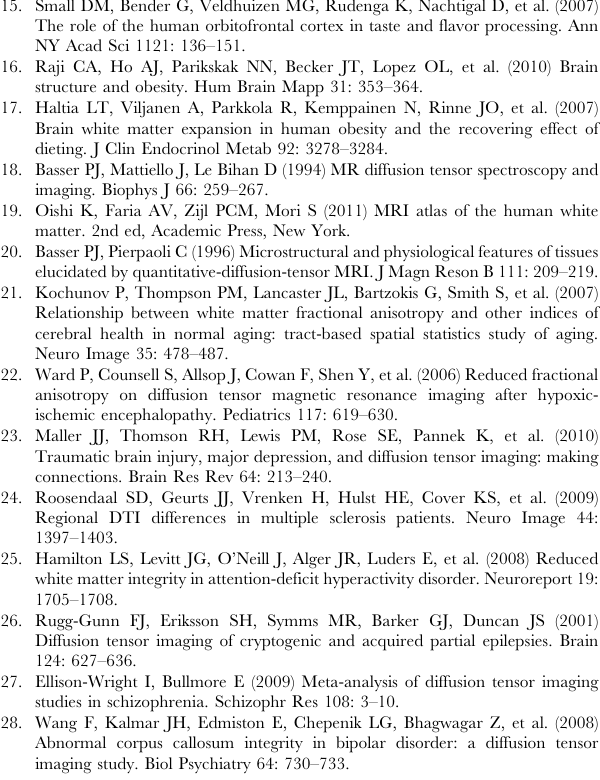
Table S1 List of subjects, with BMI and serum leptin